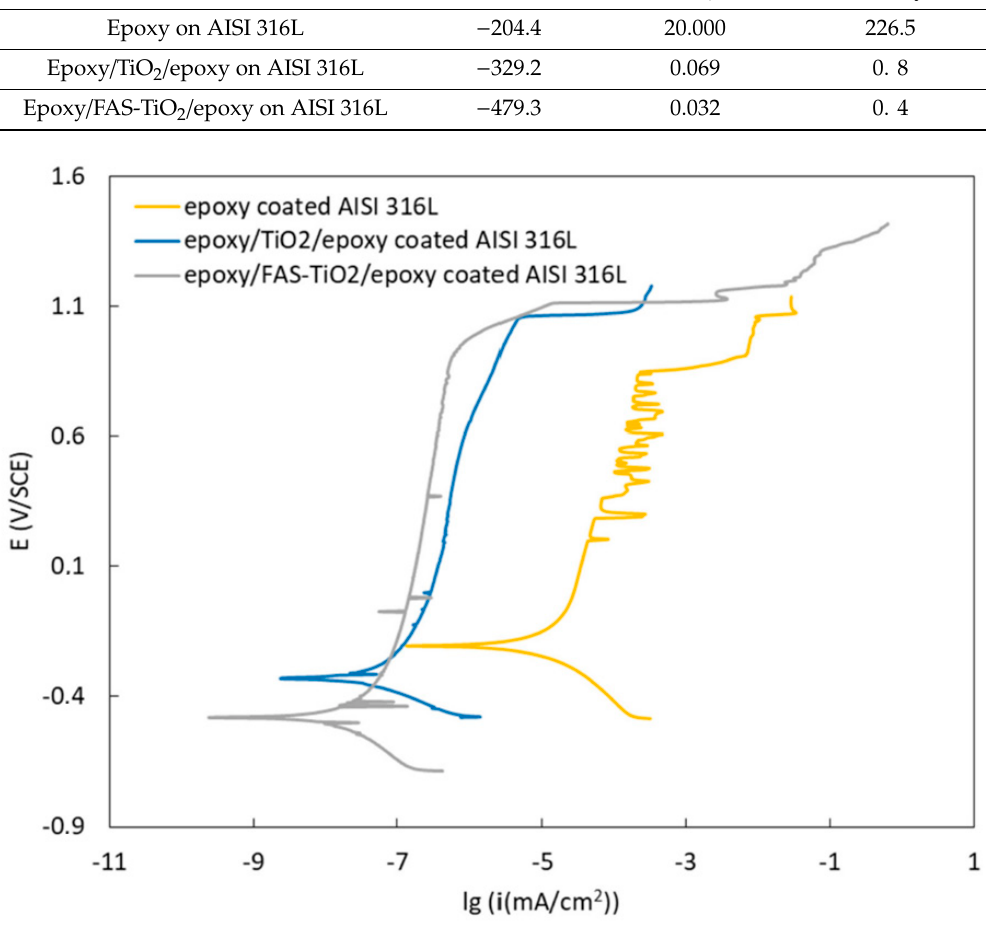
Figure 7. Potentiodynamic curves for samples in Hank’s